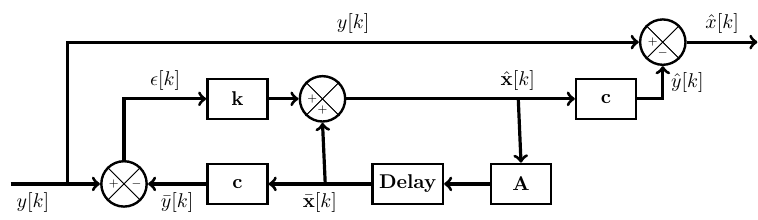
Figure 1. Working of the SSLMSWAM adaptive filter in sequential